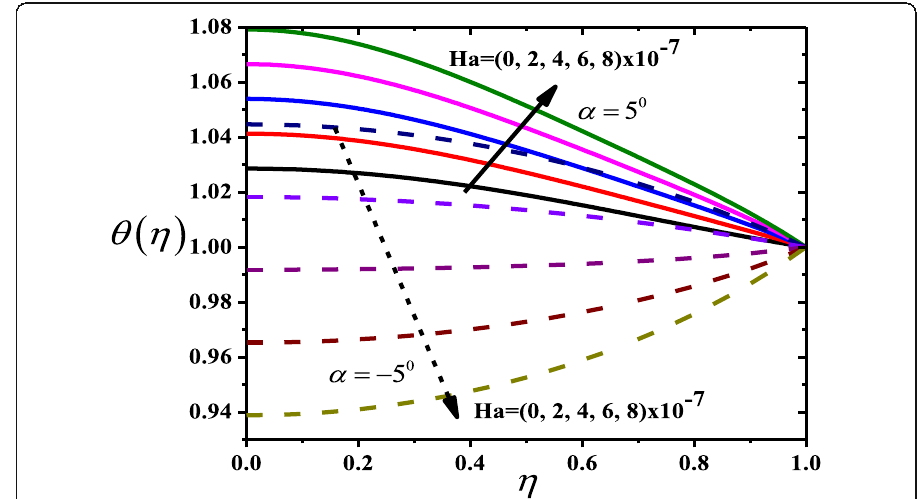
Fig. 5 Temperature vs. Ha in shrinking divergent and stretching convergent